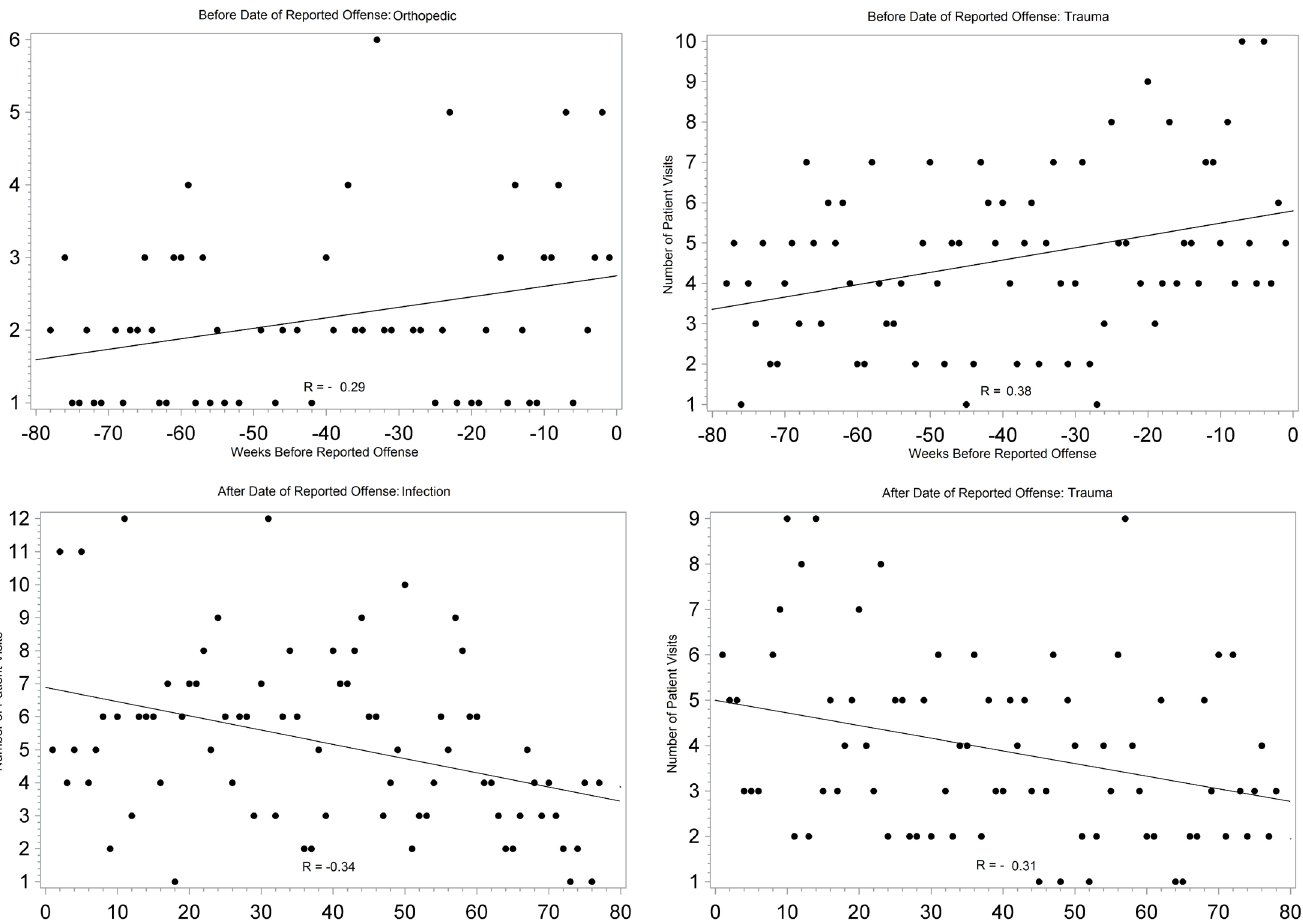
Figure 4. Correlation between number of all healthcare visits and the time from each victim’s reported date of offense within specific complaint